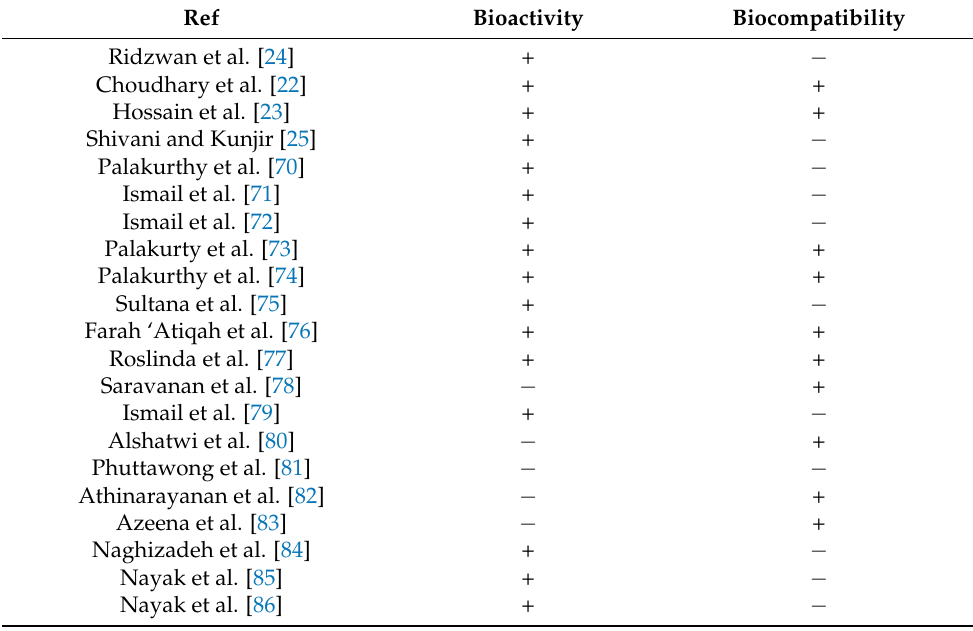
Table 7. The bioactivity and biocompatibility testing for wollastonite using rice husk ash and rice straw ash as raw